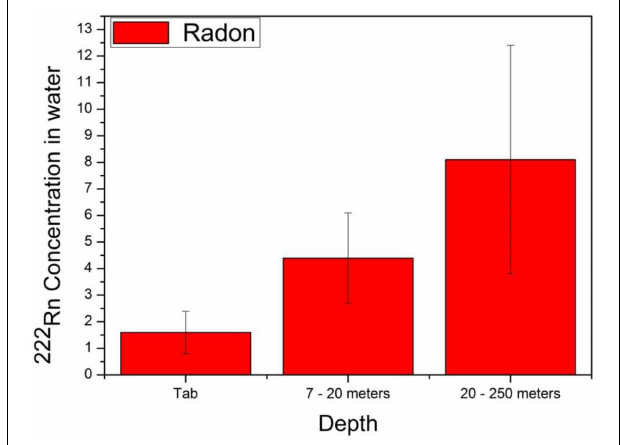
FIGURE 2 | Variation of radon concentration in water with